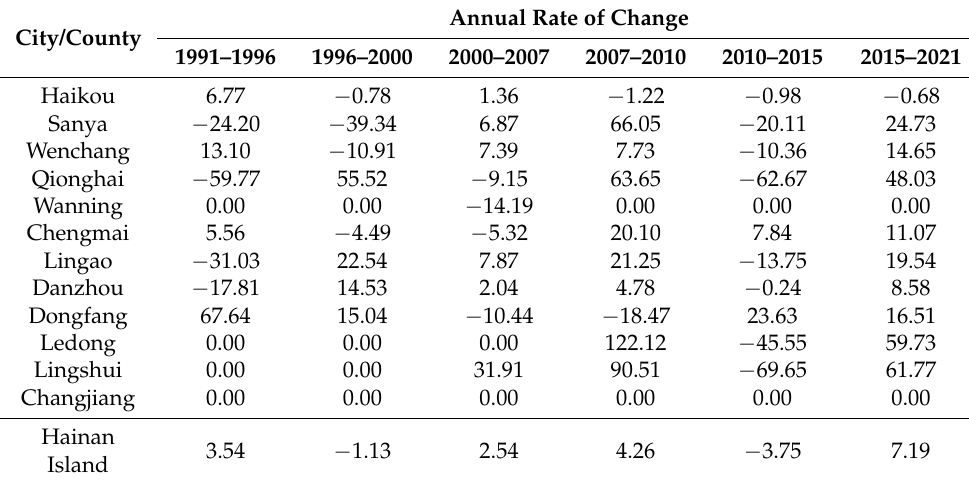
Table 5. Annual rate of change (%) in the crown surface cover area of mangrove forests in the